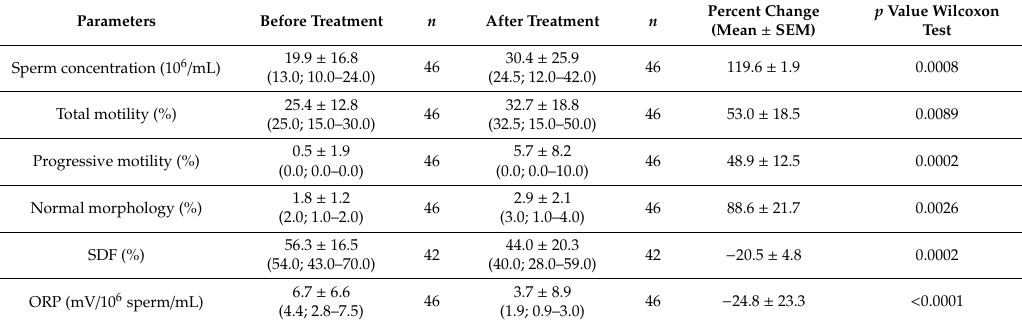
Table 5. Summary statistics of semen parameters, SDF, and ORP before and after the treatment with FH PRO for Men in idiopathic infertile patients having high ORP and SDF levels.